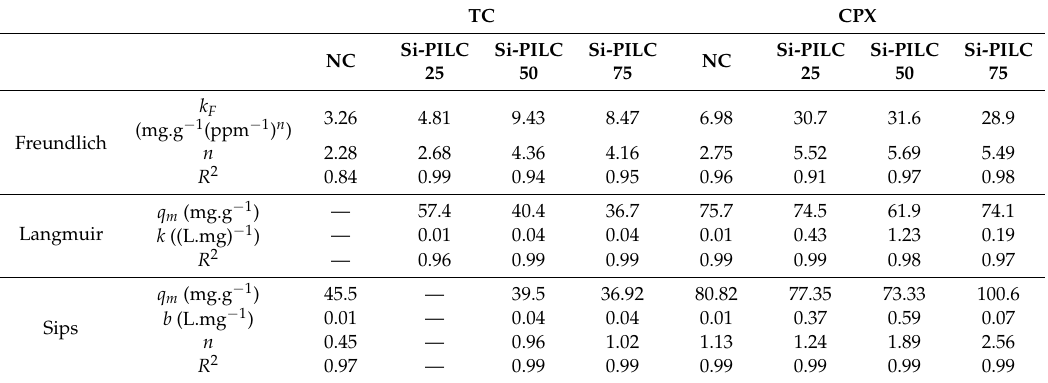
Figure 9. Experimental isotherms (symbols) and their best equations adjustments for the equilibrium adsorption data of TC and CPX on natural and pillared clays. Table 4. Freundlich and Langmuir parameters for CPX and TC adsorption on natural and pillared clay